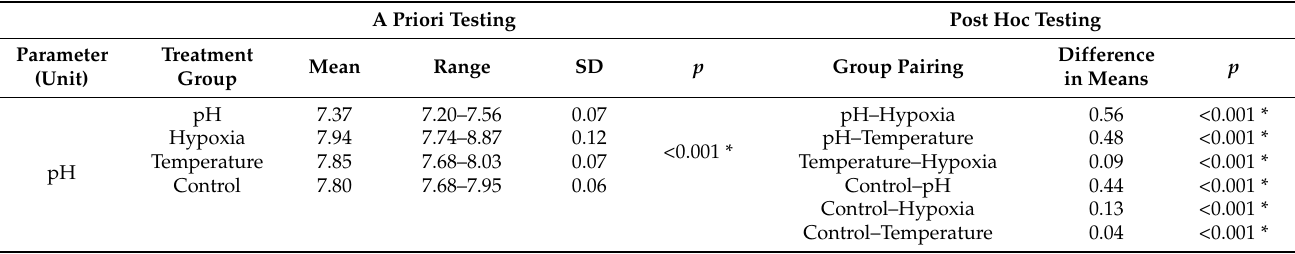
Table 1. Water quality testing results for common sea stars ( Asterias rubens , n = 60) individually housed for environmental exposures. A Kruskal–Wallis test was used to evaluate if there were differences between groups for each water quality parameter. A post hoc Dunn’s test was performed to determine which groups differed for each statistically significant difference. * Denotes statistical